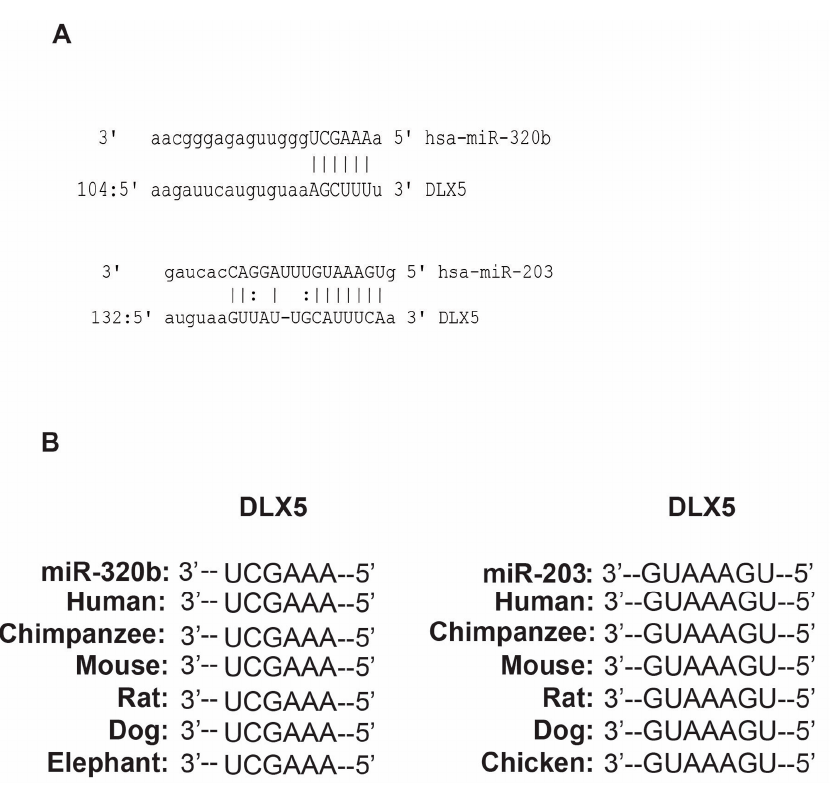
Figure 1. Putative binding sites and interspecies conservation: ( A ) the putative binding sites for miR ‐ 320b and miR ‐ 203 in the Dlx5 3 ′ UTR as predicted by TargetScan, PicTar and miRanda; and ( B ) seed sequences for miR ‐ 320b and miR ‐ 203 show conservation between species as depicted in the TargetScan alignment.